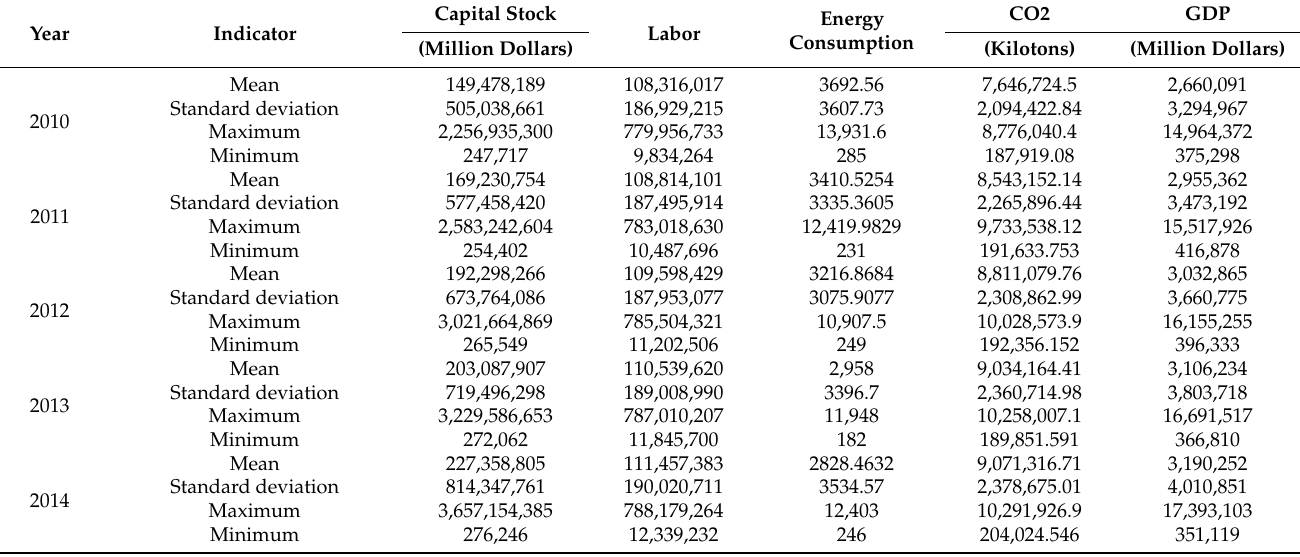
Table 1. Descriptive statistical analysis of various